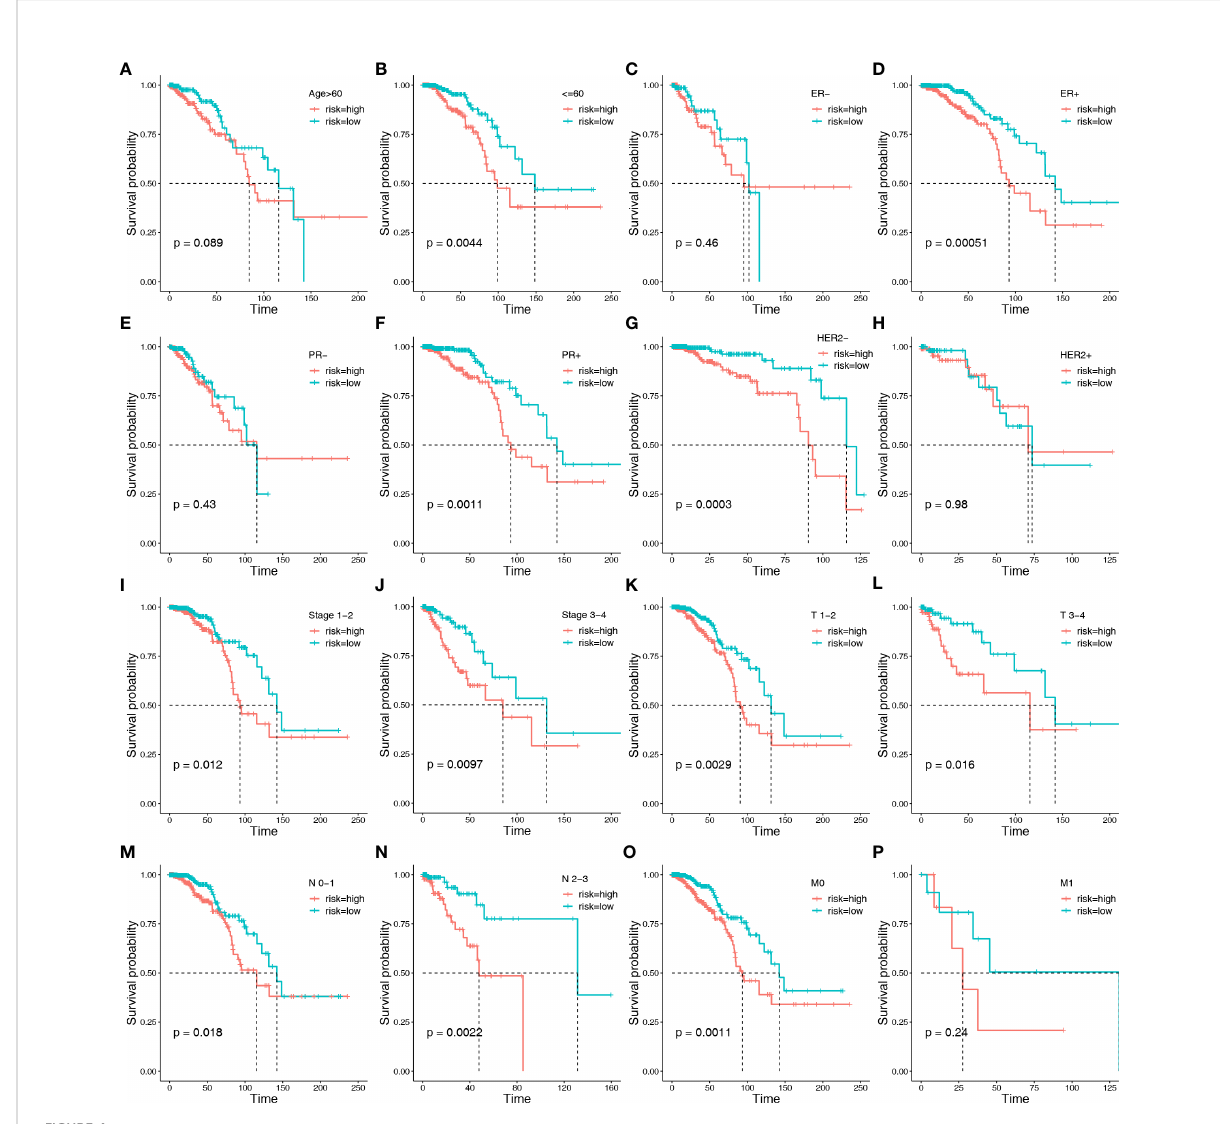
FIGURE 4 Kaplan – Meier survival analysis between the two risk groups in subgroups strati fi ed by clinical characteristics: including age [>60 years vs. ≤ 60 years] (A, B) , ER stage [negative vs. positive] (C, D) , HER2 stage [negative vs. positive] (E, F) , PR stage [negative vs. positive] (G, H) , stages [stage1- 2 vs. stage3-4] (I, J) , AJCC T stage [T1-2 vs. T3-4] (K, L) , AJCC N stage [N0-1 vs. T2-3] (M, N) , and AJCC M stage [M0 vs. M1] (O, P) ,